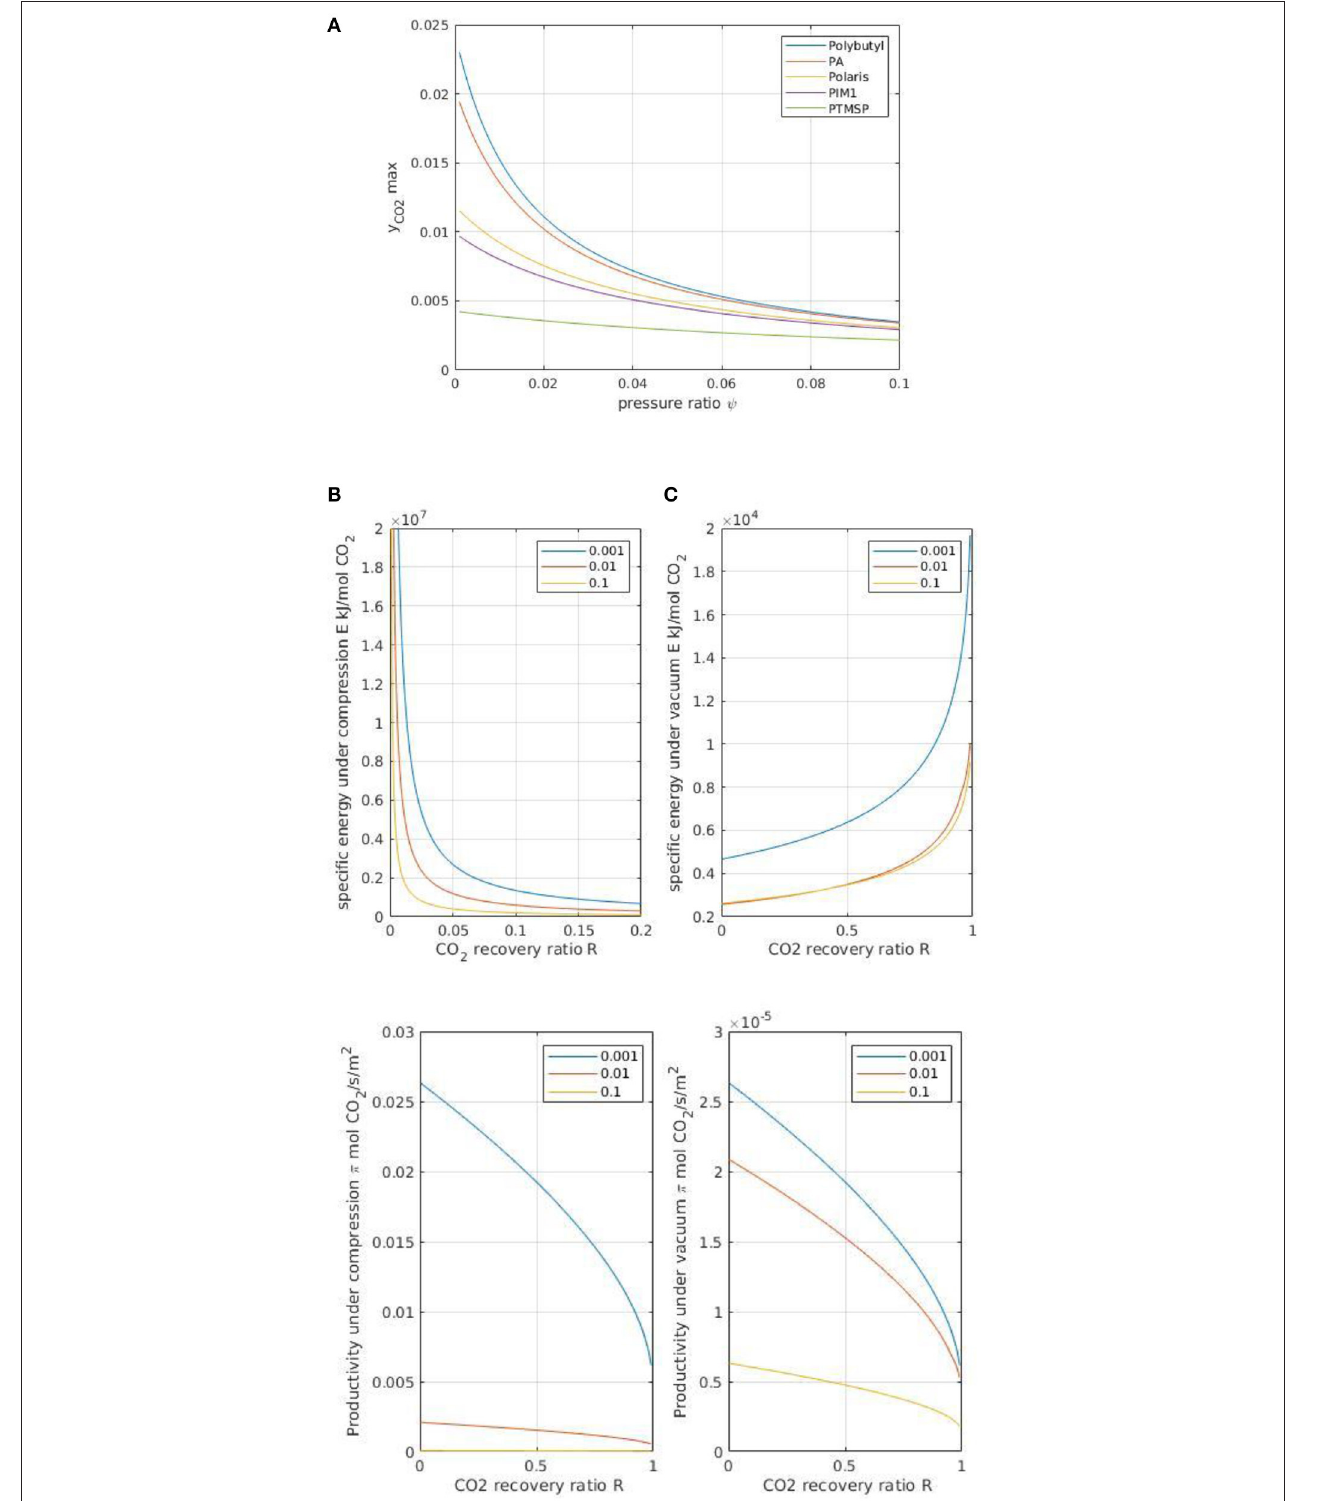
FIGURE 6 | (A) Maximal permeate purity y as a function of module pressure ratio ( ψ ) for different polymeric membrane materials (listed in Table 2 ). (B) Specific energy requirement E (expressed in kJ per mol of recovered CO 2 ) for a single-stage module under feed compression and vacuum pumping conditions and for different module pressure ratios ( ψ ). Polaris membrane, cross plug flow conditions. (C) Module productivity π (expressed in mol of recovered CO 2 per m 2 surface area) for a single-stage module under feed compression or vacuum pumping conditions and for different module pressure ratios ( ψ ). Polaris membrane, cross plug flow